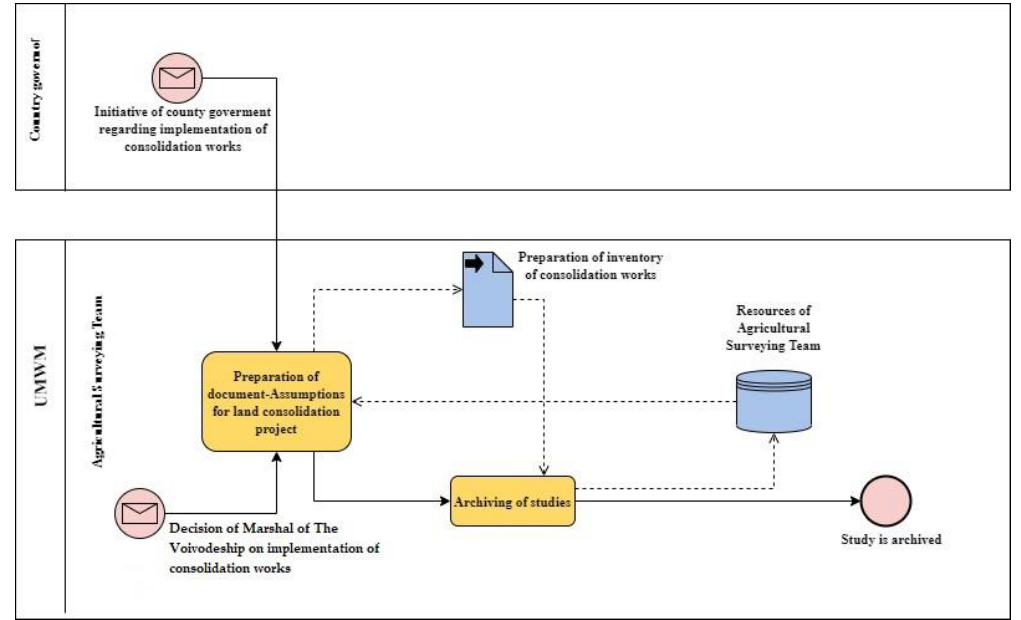
Figure 5. Developing the coordination of management and agricultural works with regard to the priority of these works. Source: own study.